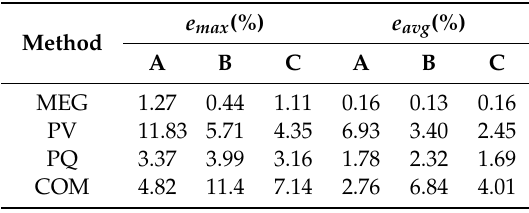
Table 6. Absolute errors of di ff erent models in Scenario